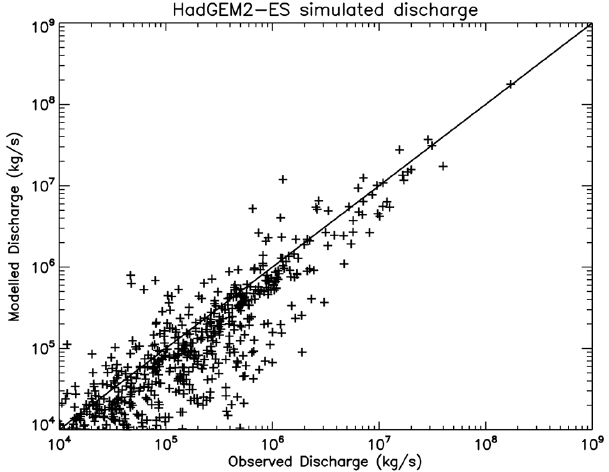
Figure 16. Simulated mean river discharge from the histori- cal HadGEM2-ES simulation against observations from Dai et al. (2009).